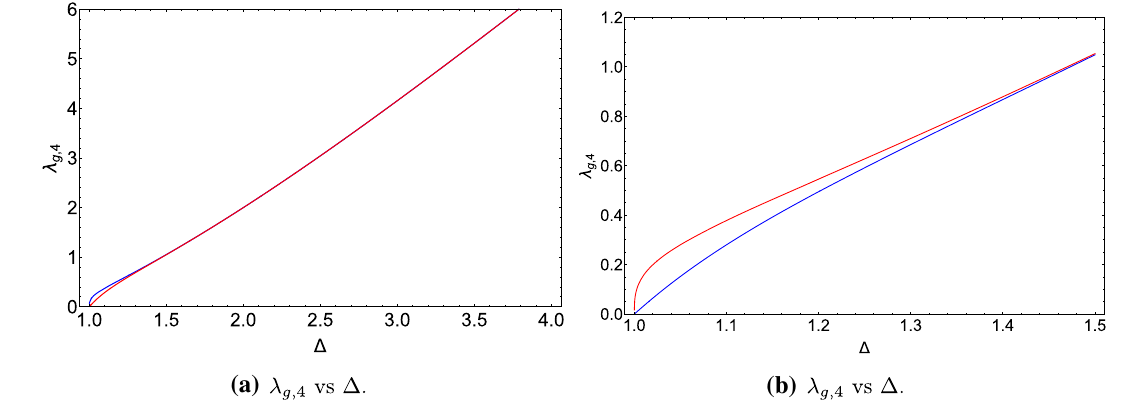
Fig. 24 a λ g , 4 vs (cid:2) : blue and red colored curves for λ g , 4 are obtained by letting d N = 0, with N = 29 , 30 respectively. There are two branches in 1 < (cid:2) < 3 / 2. And such branches merge for (cid:2) ≥ 3 / 2. b Zoom in on the left